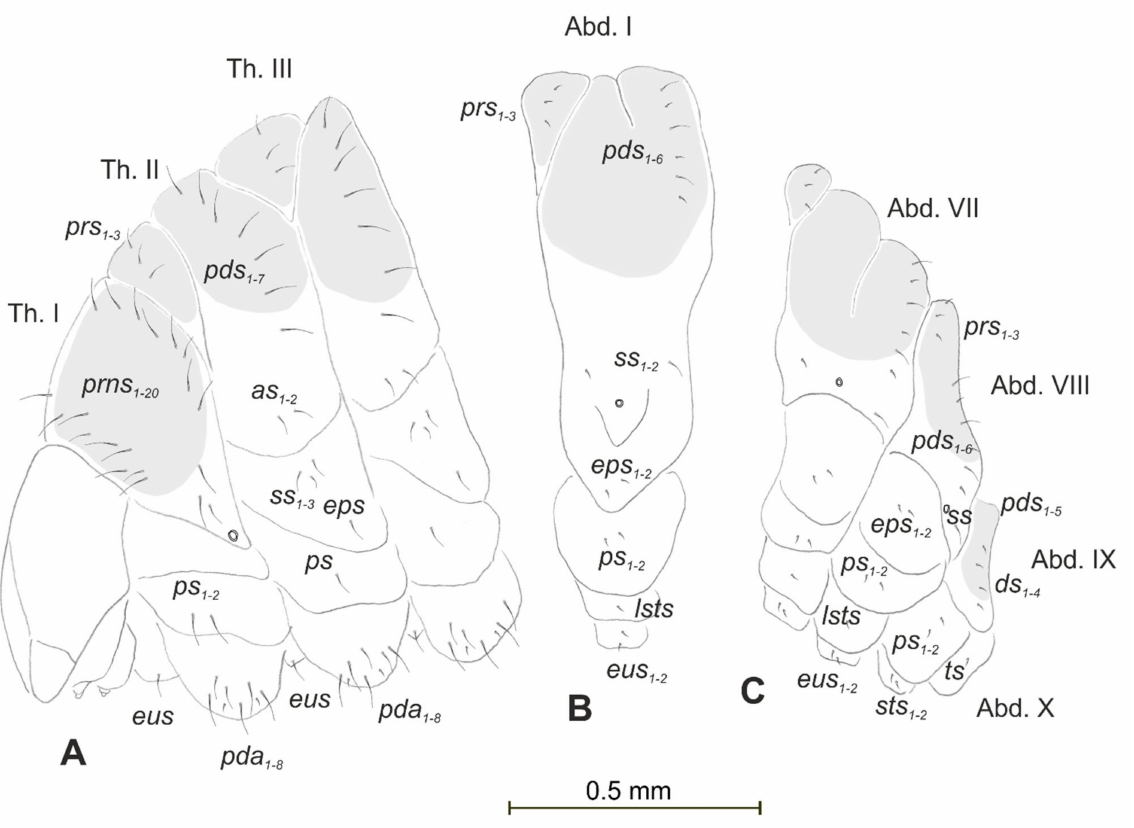
Figure 2. Lachnaeus crinitus mature larva, chaetotaxy. ( A )—lateral view of thorax; ( B )—lateral view of abdominal segment I; ( C )—lateral view of abdominal segments VII–X (Th. I–III—thoracic segments 1–3, Abd. I–X—abdominal segments 1–10, setae: as —alar, ds —dorsal, ps —pleural, eps —epipleural, eus —eusternal, pda —pedal, pds —postdorsal, prns —pronotal, prs —prodorsal, ss —spiracular, sts —sternal, ts